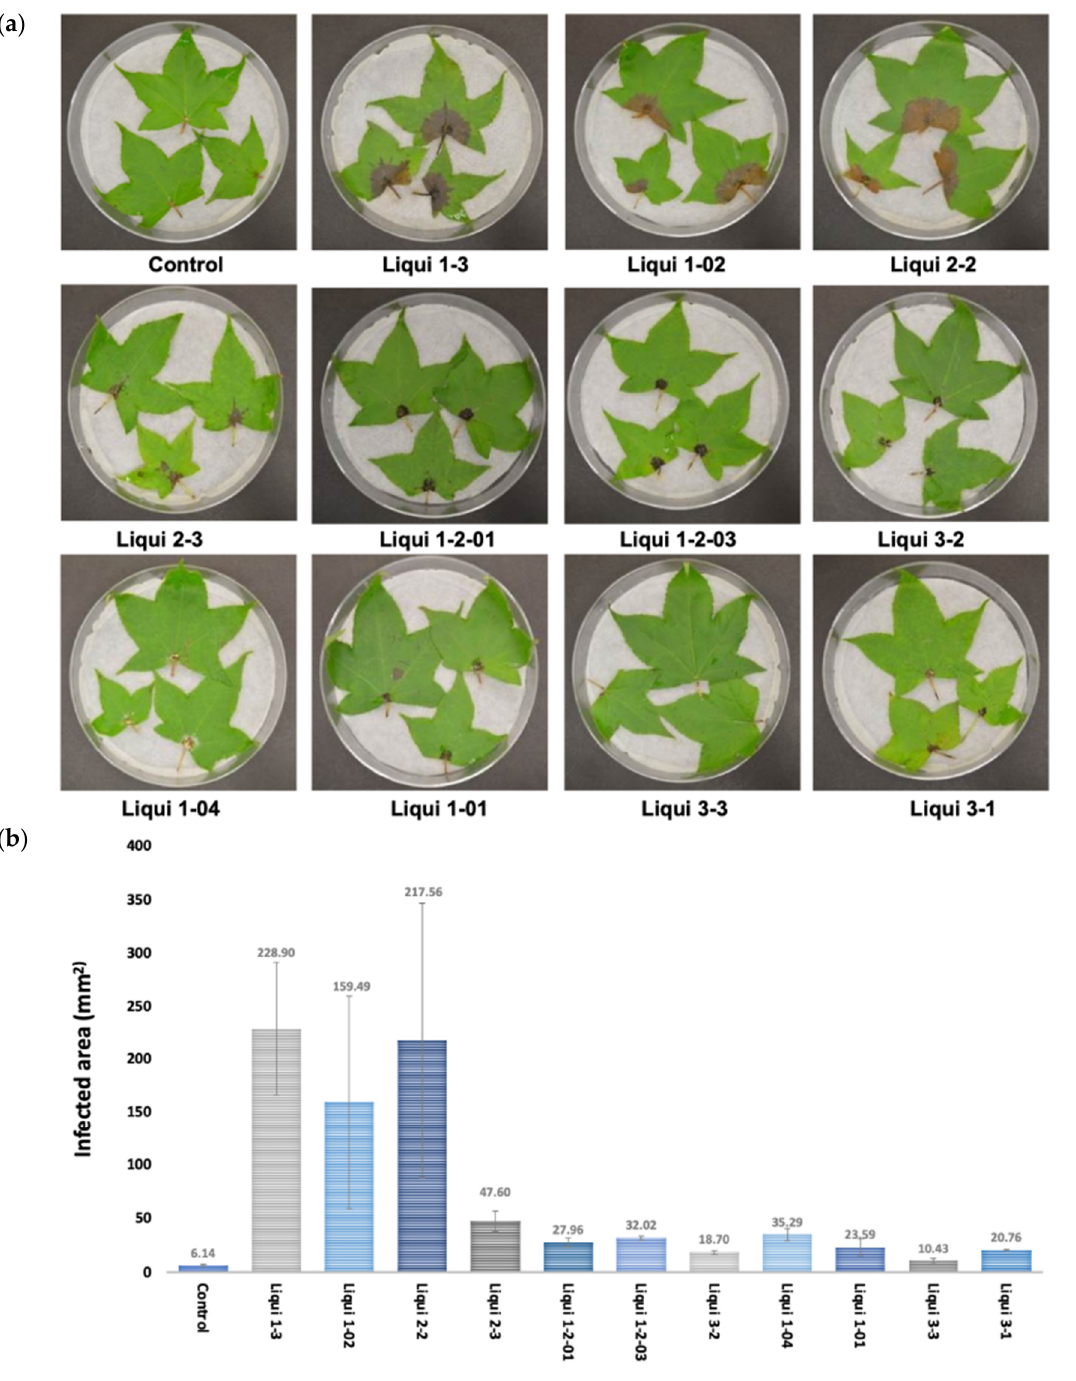
Figure 1. Pathogenicity screening of the different fungal isolates in L. styraciflua leaves. ( a ) Liquidambar styraciflua leaves were collected from adult trees and infected with different fungal isolates. The photograph was taken at 7 dpi. The data are representative of three independent experiments. ( b ) The graph presents the area values of damaged tissue in mm 2 .